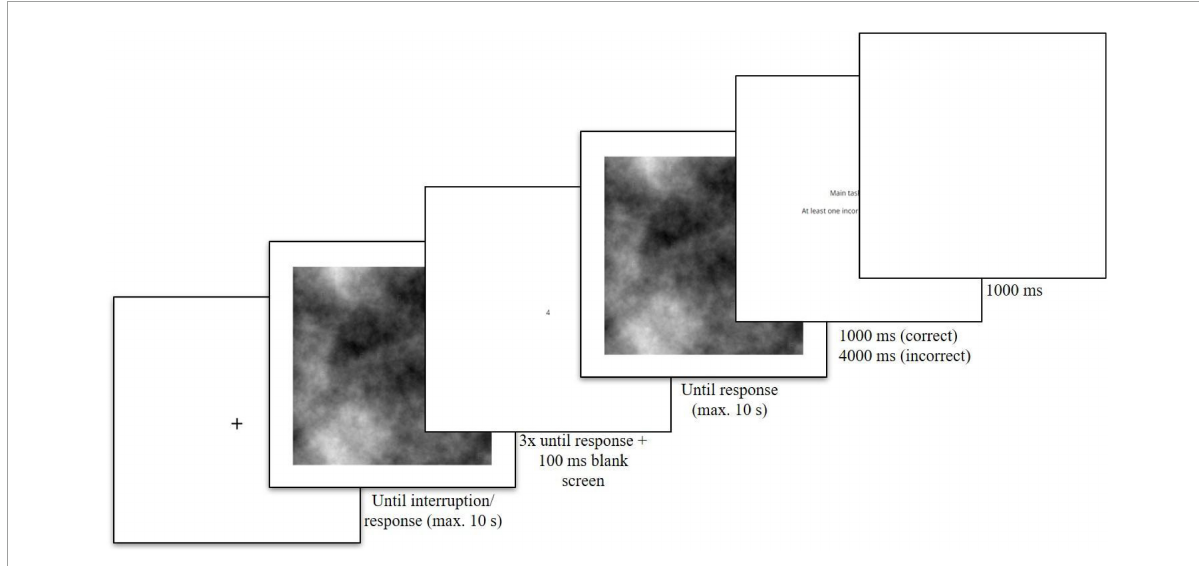
FIGURE1 Example trial procedure with an interruption. Note that the number classification task appeared three times (i.e., required three responses). In trials without an interruption, of course only the first response screen was